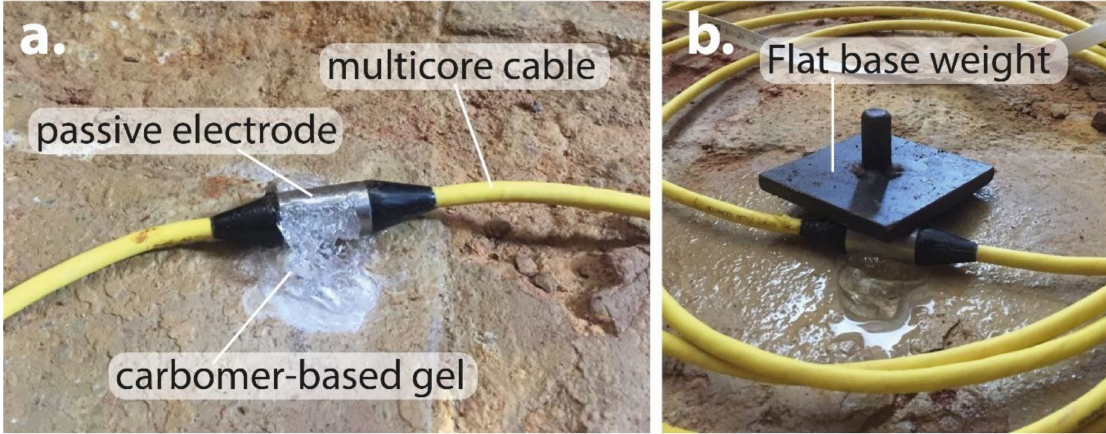
Figure 4. ( a ) Detail about added carbomer-based gel on the passive electrode surface, and ( b ) flat-base metal weight placed on the passive